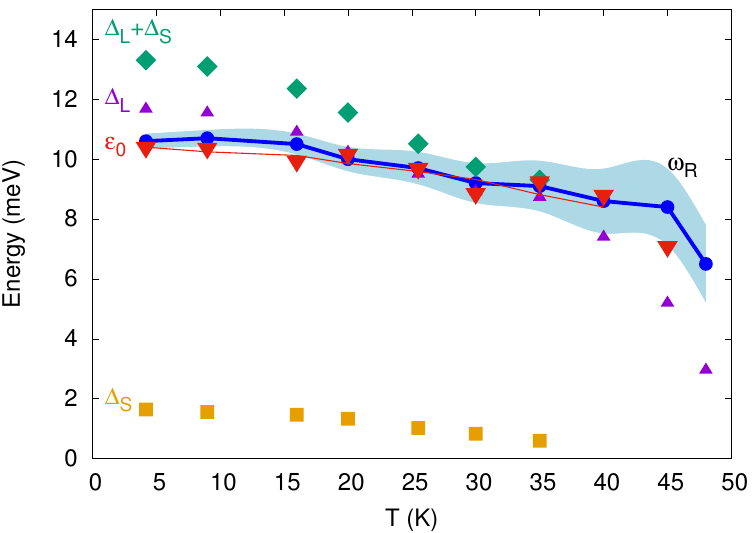
Figure 2. Temperature dependence of the measured large gap ∆ L (violet triangles), measured and extrapolated small gap ∆ S (orange squares), their sum ∆ L + ∆ S (green rhombuses), and the measured bosonic energy ε 0 (red triangles). The averaged ε 0 ( T ) experimental dependence is shown by a thin red curve. Calculated energy of the spin resonance ω R (blue dots) is shown together with the uncertainty in its determination (inversely proportional to the spin resonance peak height, wide light blue region around the blue